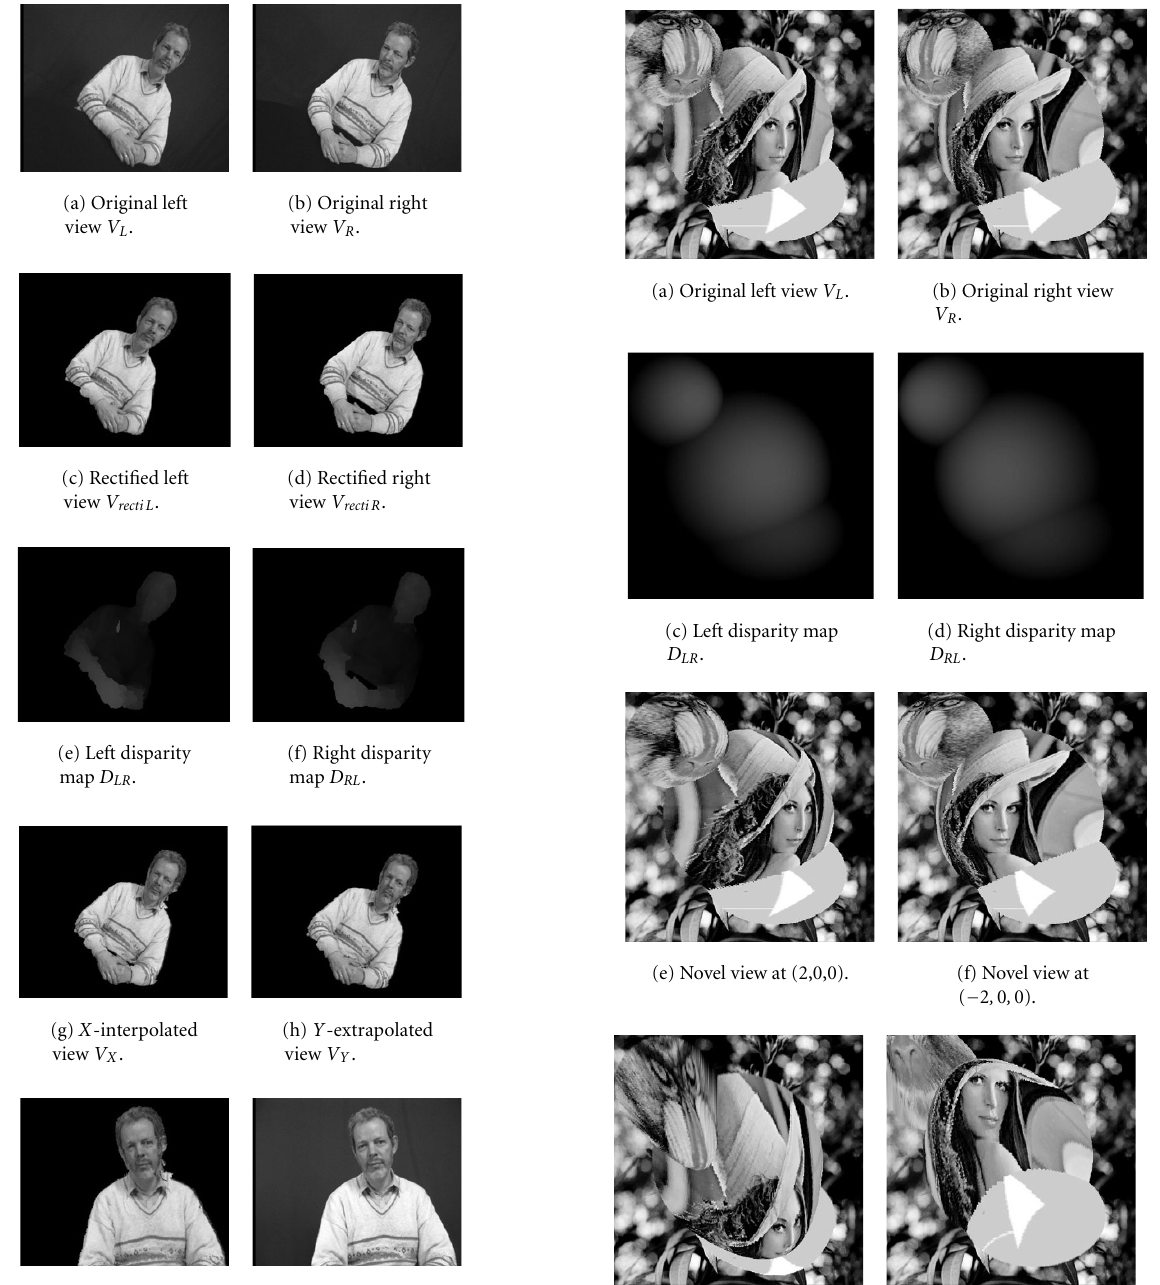
Figure 15: Novel views at di ff erence poses reconstructed from the synthetic stereo pair (a) and (b) by our multi-step algorithm based on the ground-truth disparity maps (c) and (d). Clear feeling of viewpoint movement can be perceived.